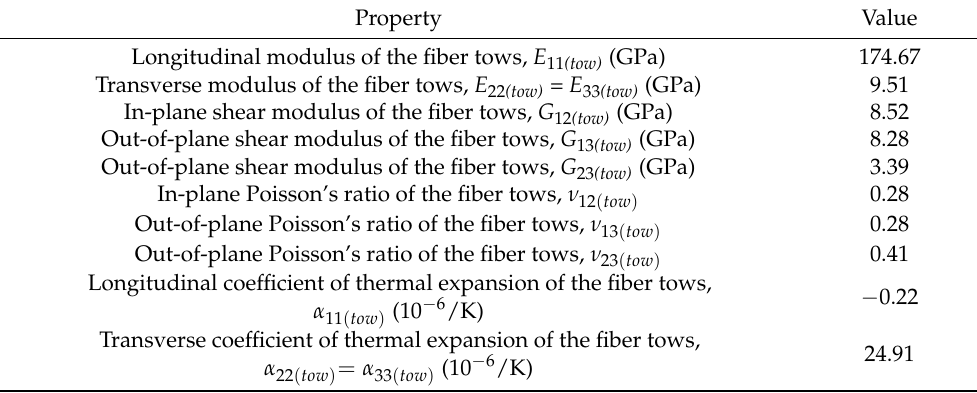
Table 9. Mechanical properties of the fiber tows in the meso-scale FE model of the T300/Epoxy PWF